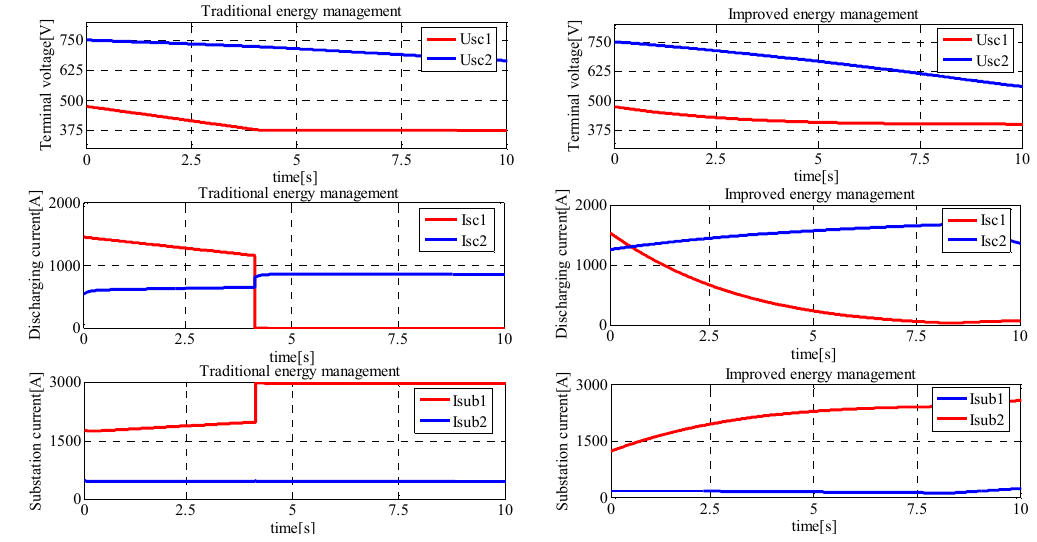
Figure 14. Terminal voltage and discharging current of ESSes.